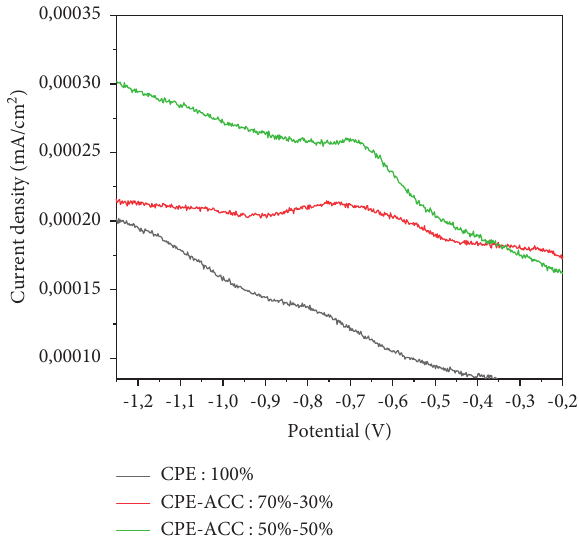
Figure 1: CPE-ACC SWV responses at different proportions (Hg/Hg